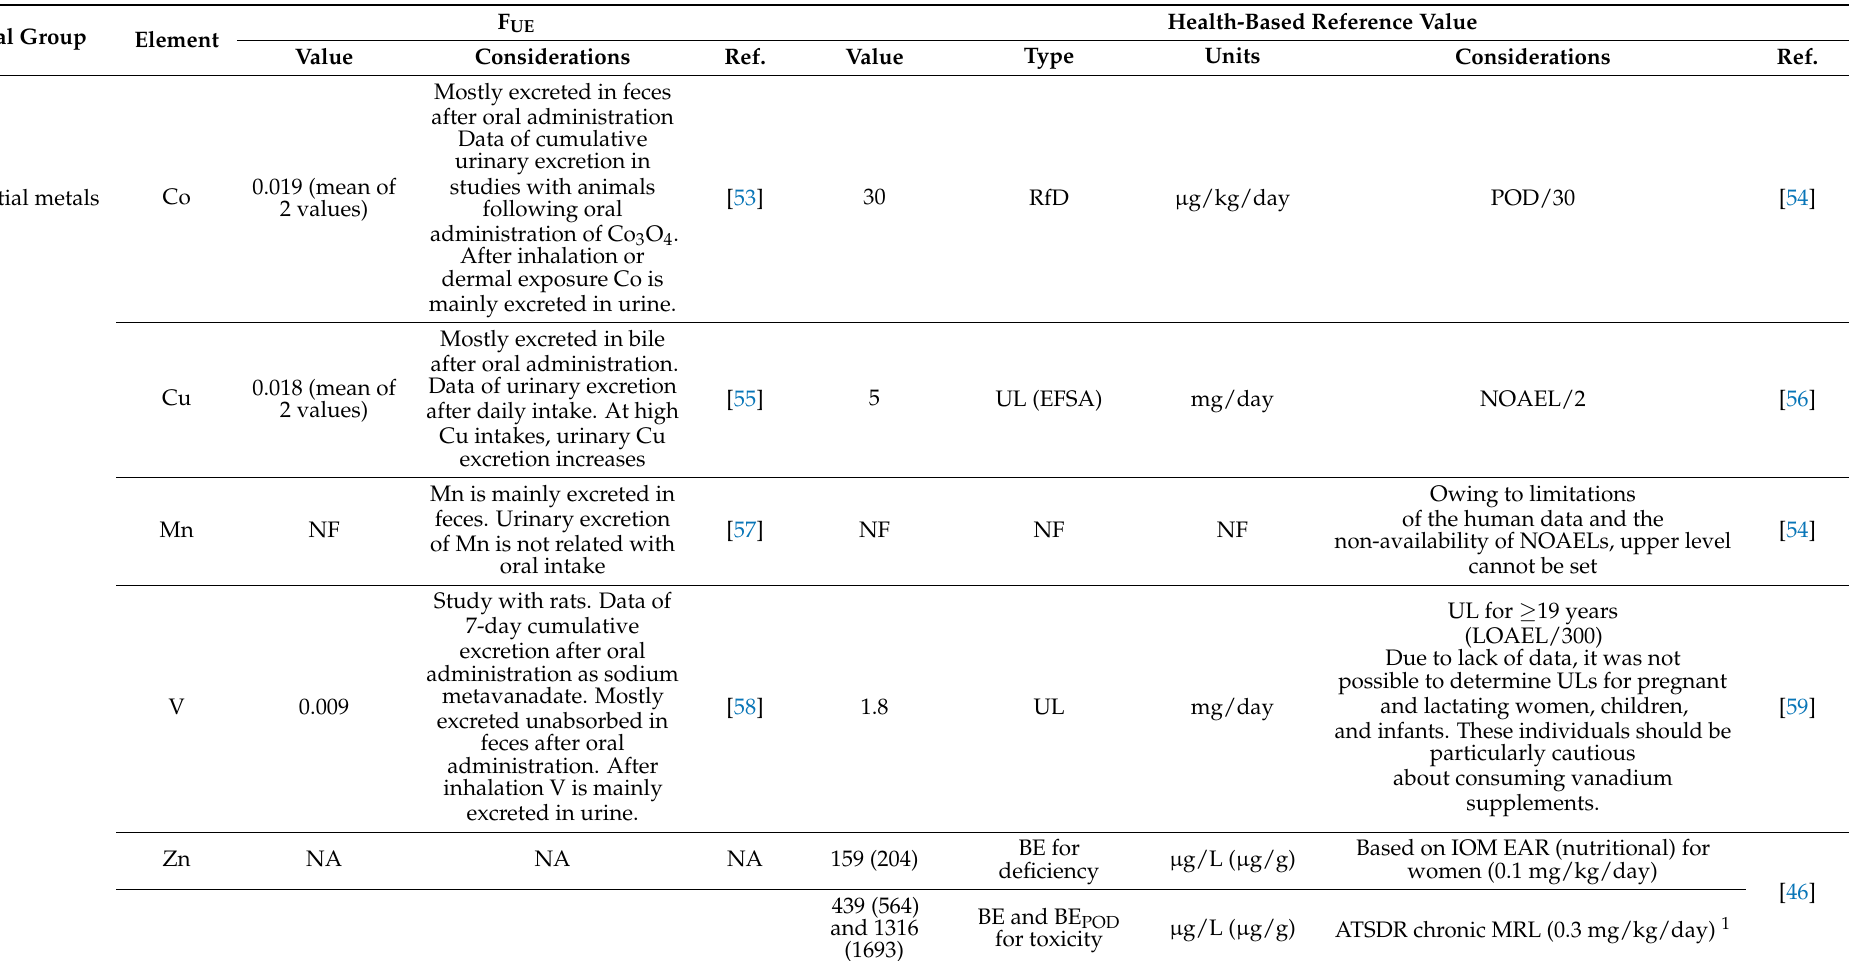
Table 1. Urinary excretion factors and health-based reference values of the elements used for the risk